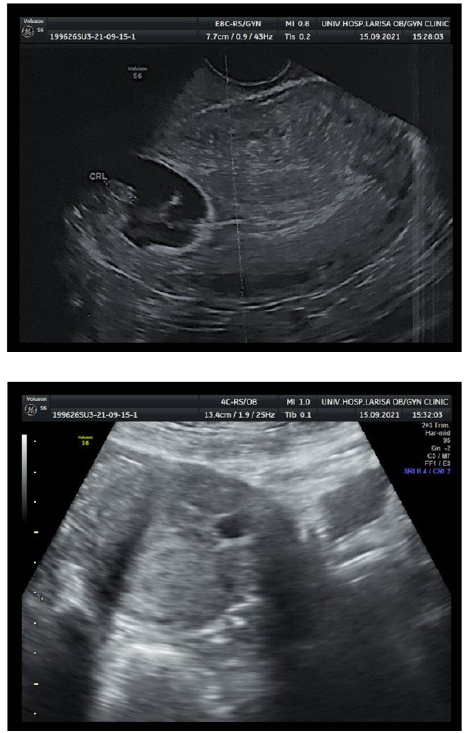
Figure 1. Transvaginal ultrasound showing the gestational sac attached to the caesarean scar. Initially, after informing the patient accordingly and obtaining written consent, an unsuccessful attempt for pregnancy termination by injecting potassium chloride (KCl) in the gestational sac by ultrasonographic guidance was performed [6–9]. One day later, despite the elevated β -HCG levels, a decision for medical management with systemic methotrexate (MTX) therapy CSP was made and informed consent was obtained. Based on the protocols, intramuscular administration of a single 8.5 MTX dose (calculated by the equation 50 mg/m 2 ) was given [10,11]. Sequential β -hCG levels and TVS were planned [12]. The initial serum levels of β -hCG were 46,407 mIU/mL. Four days after systemic methotrexate administration, β -hCG serum levels continued to rise (52,257 mIU/mL) while a new transvaginal scan revealed a smaller gestational sac with normal shape. On the 7th day after initial MTX administration β -hCG levels reached 52,839 mIU/mL, the patient continued to be asymptomatic, with no vaginal bleeding nor abdominal pain or tenderness and TVS findings remained unchanged (Figure